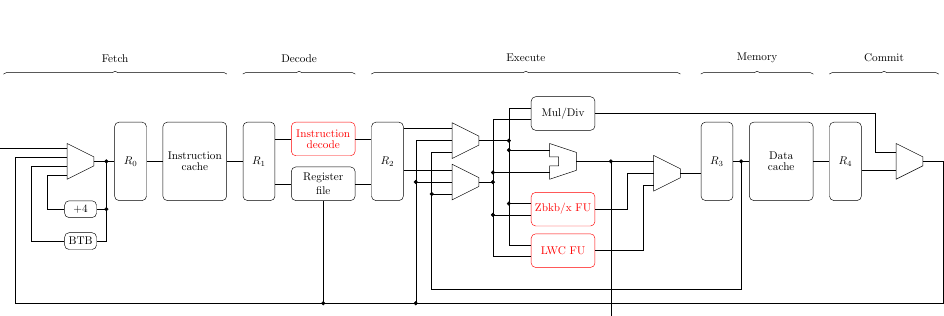
Figure 2: A block diagram highlighting features in our hardware implementation (e.g., integration of the Zbkb/x and LWC FUs) in red. Note that R register, the component labelled Mul/Div supports multiplication and division, and a Branch Target Buffer (BTB) is shown toward the left-hand end of the